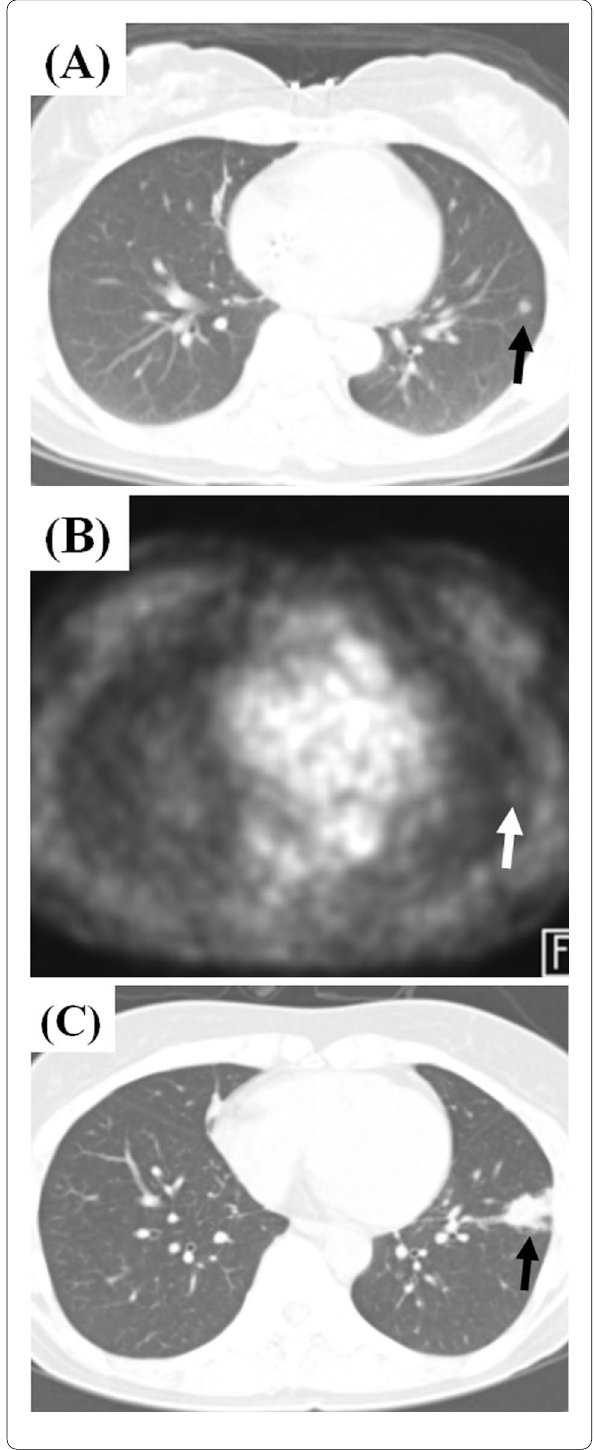
Fig. 3 Representative CT and 18‑fluorodeoxyglucose PET images showing incipient TB progressing into active tuberculosis disease in a 60‑year‑old female with malignancy. a, b CT and PET images for metastasis work‑up shows a small single incidental nodule with subtle hypermetabolism in the left lobe lobe (black arrow). There was no metabolic uptake in mediastinal lymph nodes. ( c ) A follow‑up CT image 6 months later reveals the increasing size of the nodule with micronodular infiltration (black arrow). The patient still denied any symptoms and signs. The sputum smear and culture was negative for Mycobacterium tuberculosis . The specimen of percutaneous transthoracic lung biopsy turned to be chronic granulomatous inflammation with necrosis, consistent with active tuberculosis